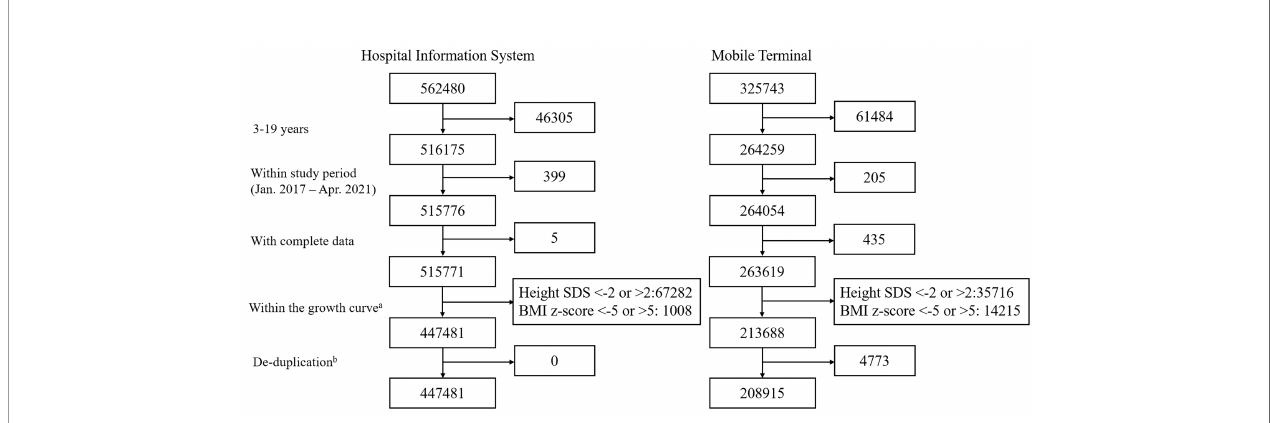
FIGURE 1 | Flow chart of sampling procedure. a To remove the cases that might had growth disorder, we only included the cases whose height age- and sex- speci fi c SDS was between ±2. Then cases with BMI z-score higher than 5 or lower than -5 were excluded in order to excluded incorrect entries and weight abnormalities that might be secondary to other diseases. b Each child had a unique ID. Cases that repeatedly registered data in both the hospital database and the mobile database were regarded as repeated cases, and data from mobiles were